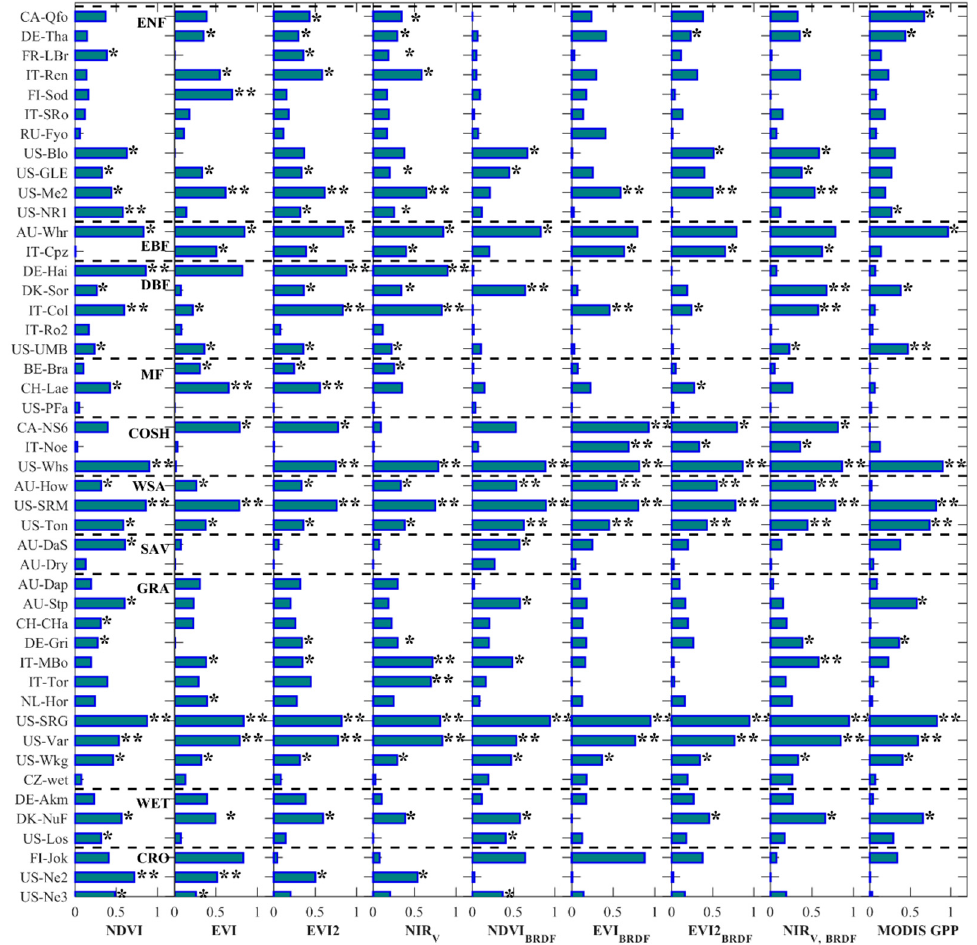
Figure 3. The bar graphs of the R 2 values for the relationships between the annual averaged VIs and tower GPP for all the sites with at least six years of flux data for each biome. The letters on the x axis stand for the R 2 values; the letters on the y axis stand for the sites. The asterisks - * and ** stand for the significance level p < 0.1 and p < 0.05, respectively. The biome types are as follows: evergreen needleleaf forest (ENF); evergreen broadleaf forest (EBF); deciduous needleleaf forest (DNF); mixed forest (MF); closed and open shrublands (COSH); woody savannas (WSA); savannas (SAV); grasslands (GRA); wetlands (WET); croplands (CRO).